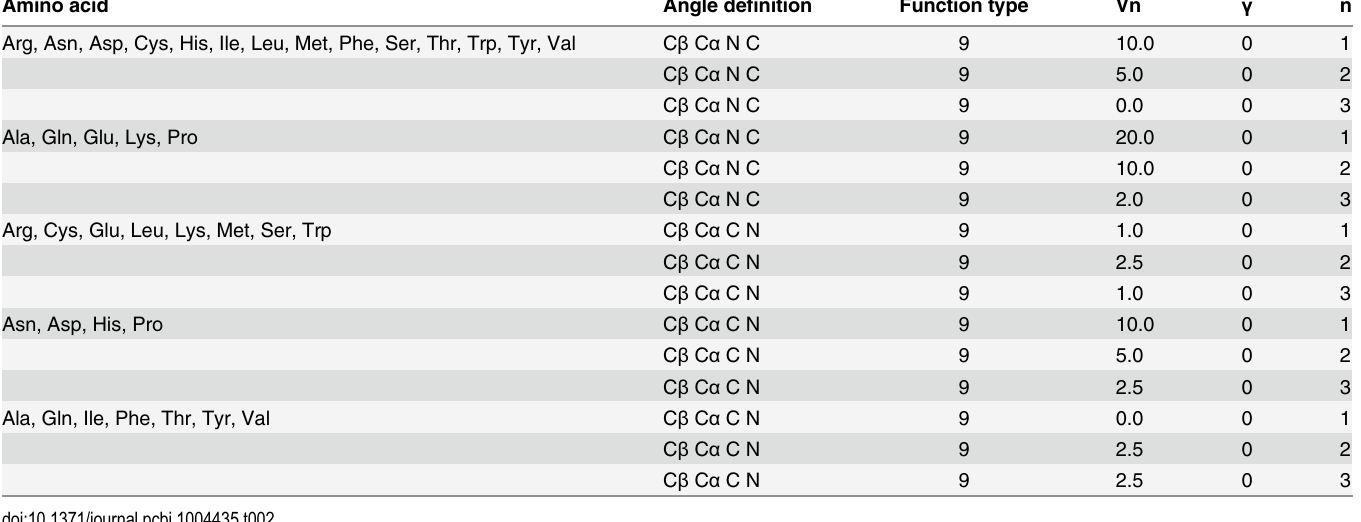
Table 2. Parameters for C β -C α -N-C' and C β -C α -C'-N dihedral angles used in the CamTube force field that encode the propensity of the amino acids for different regions in the Ramachandran map. Amino acid